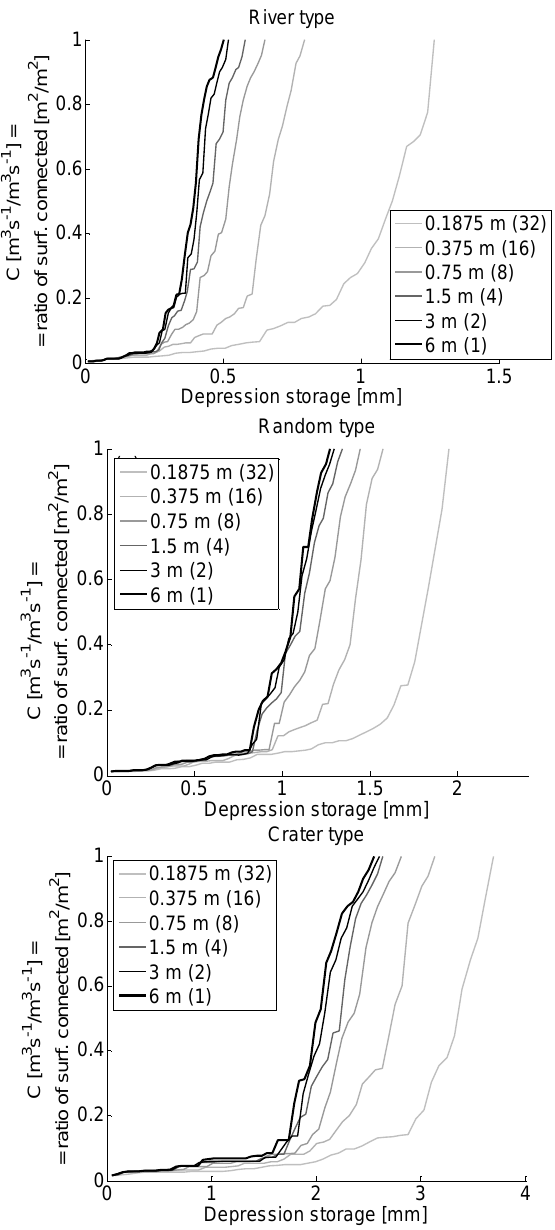
Fig. 8. Synthetic fields – effect of plot width on the averaged RSC function for the river, random and crater type microtopographies. The numbers in parentheses indicate the number of connectivity curves used for calculating the average RSC functions. All plots are 6m